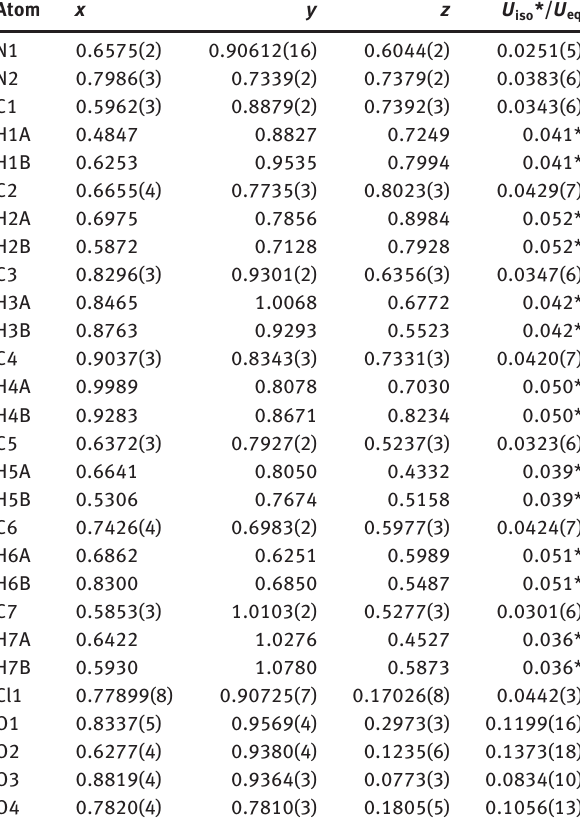
Table 2: Fractional atomic coordinates and isotropic or equivalent isotropic displacement parameters (Å 2